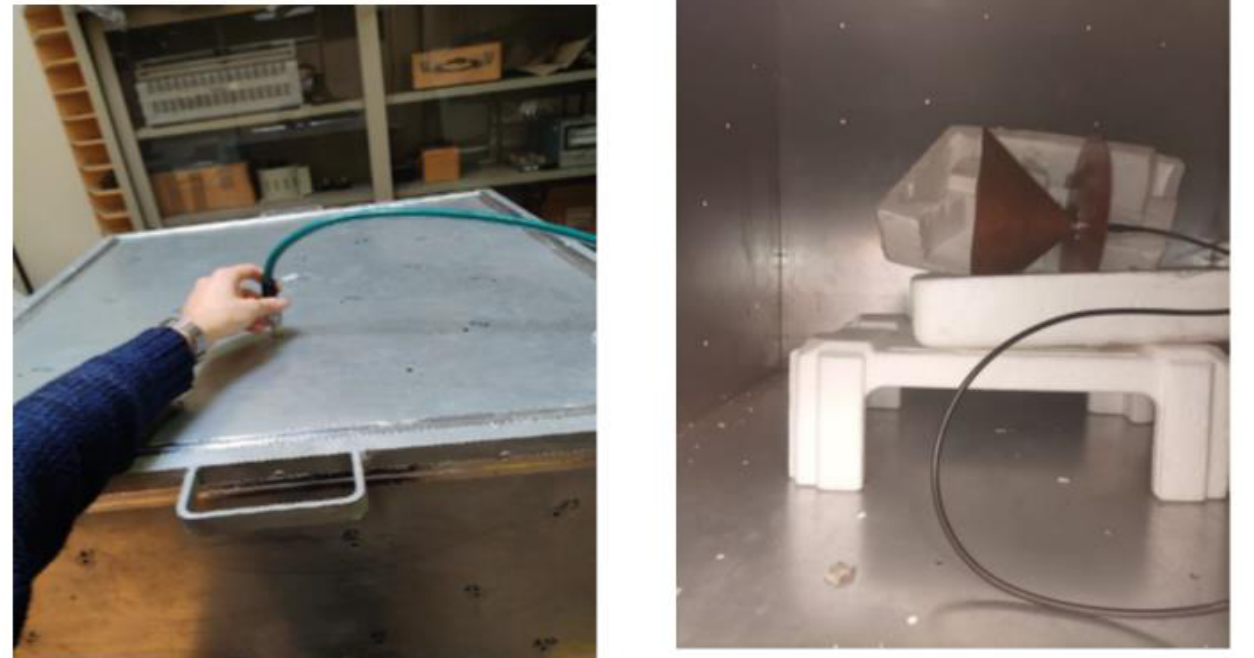
Figure 7. Insertion of the transmitting monopole (left) and the location of the receiving antenna (right) inside the RC. Each hole, clearly visible from the inner view, is subsequently used to insert the transmitting monopole toward the chamber inside.